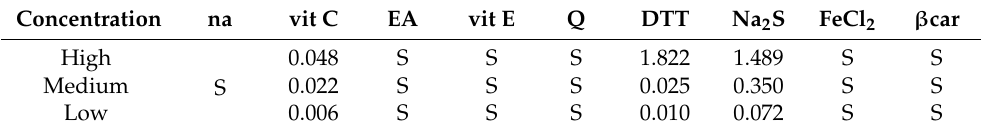
Table 3. Stability of oCoQ10, expressed by first-order constant (day − 1 ), in the presence of different concentrations of antioxidants and reducing